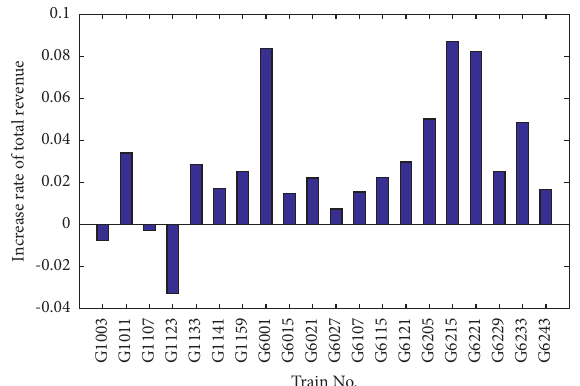
Figure 9: Optimization process curve of large-scale numerical instance.